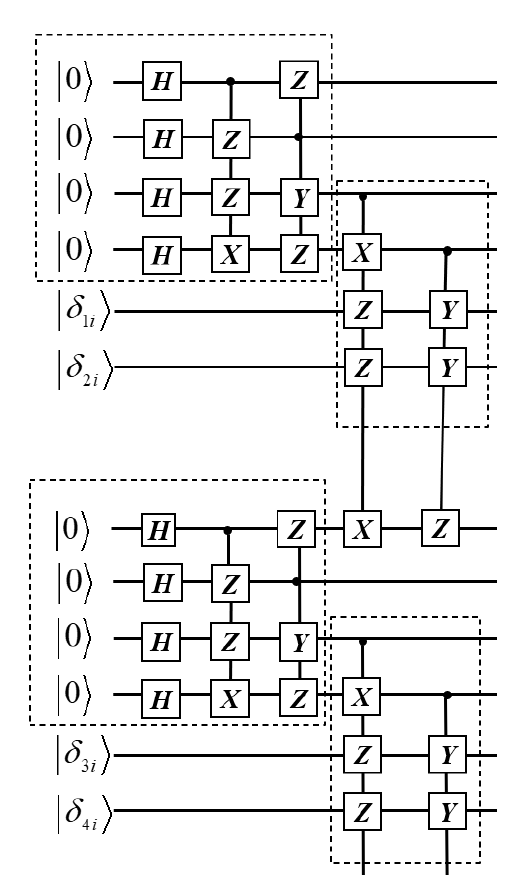
Figure 4. The block method of the [6, 2, 2] quantum convolutional